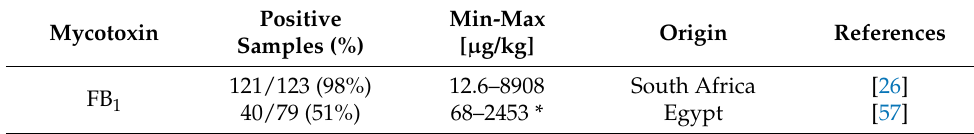
Table 4. Natural occurrence of free and modified mycotoxins in